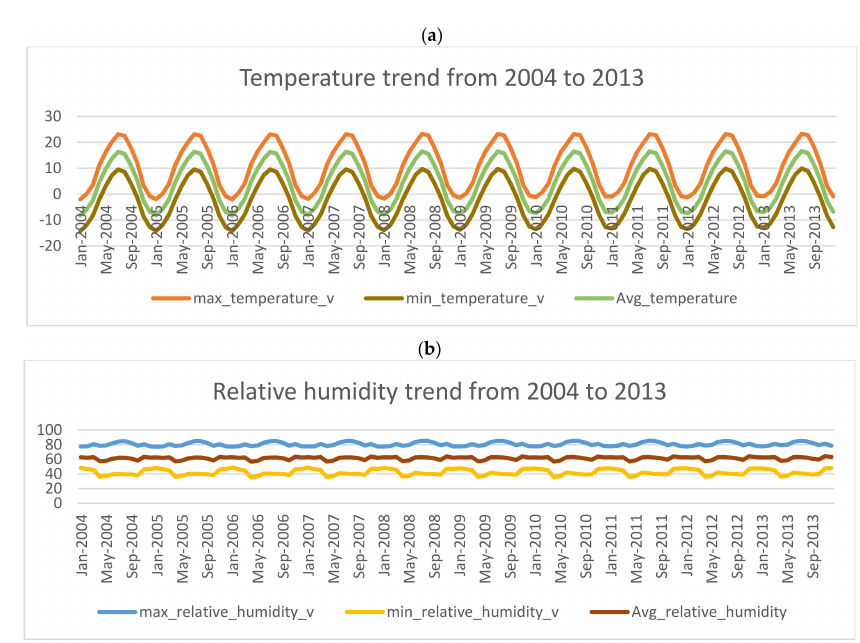
Figure A1. Time series of monthly temperature ( a ), relative humidity ( b ).